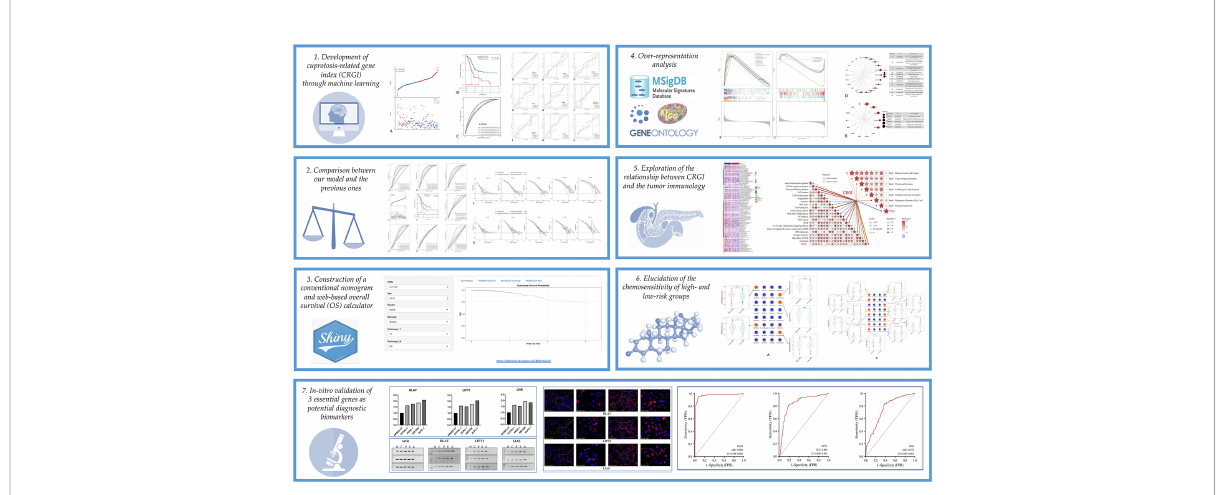
FIGURE 1 Graphical abstract of the present